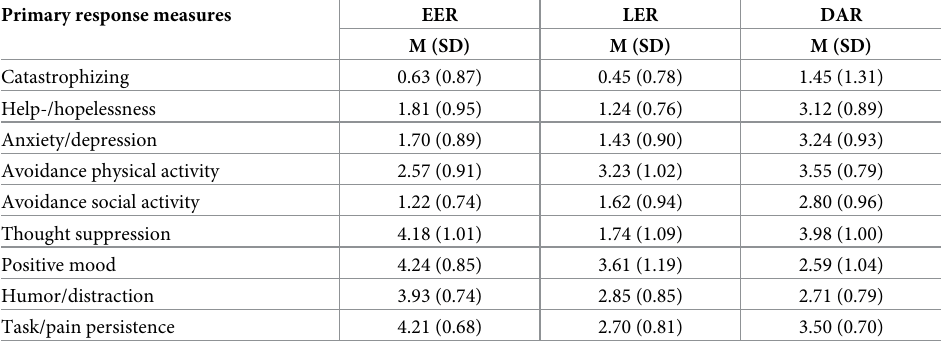
Table 4. Means and standard deviations of pain response profiles in primary response